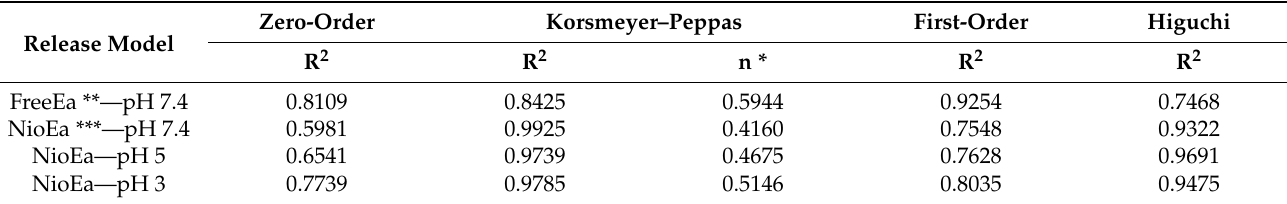
Table 4. The kinetic release models and the parameters obtained for optimum niosomal formulation. * Diffusion or release exponent; ** Free E. angustifolia; *** E. angustifolia -loaded niosome. Release